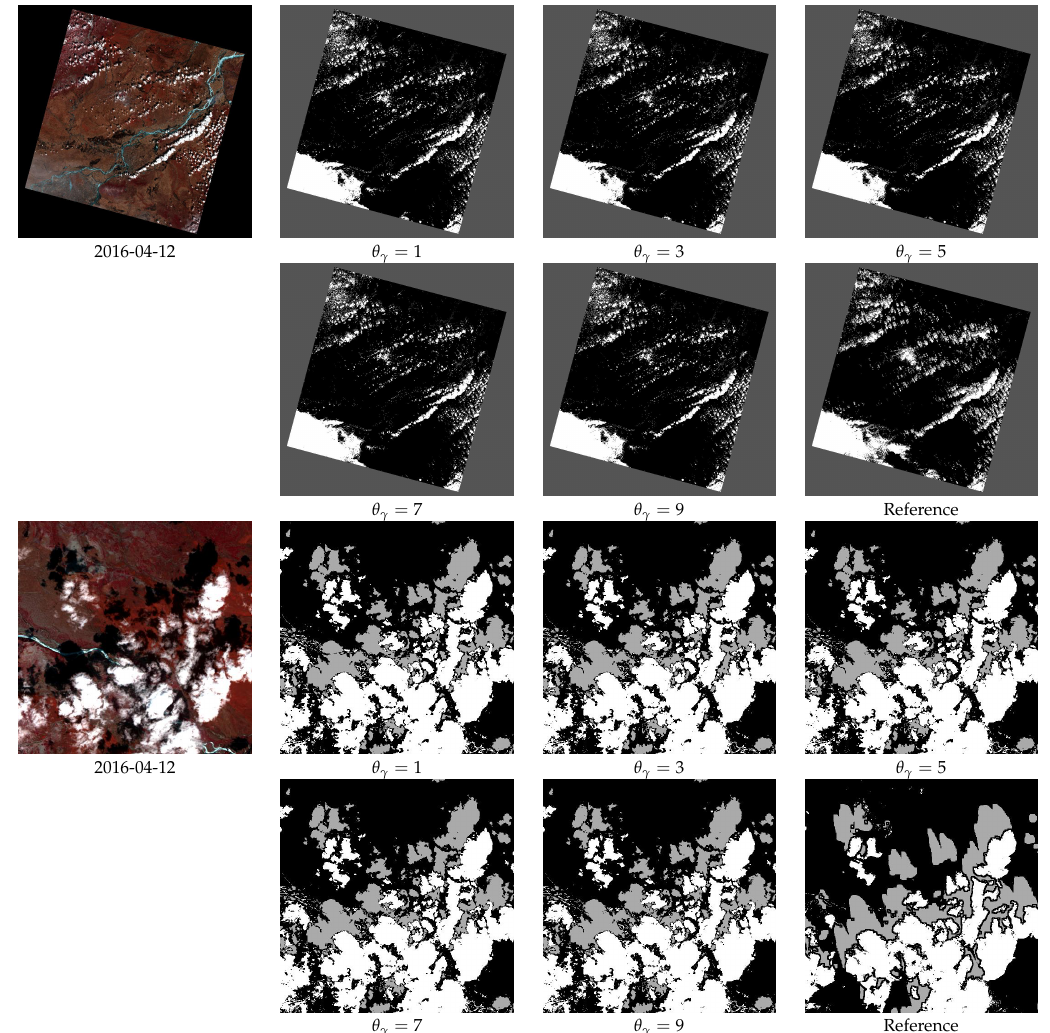
Figure 12. Visualizations with regards to θ γ of Dense CRF postprocessing. The candidate values of θ γ vary from 1 to 9 while θ α and θ β are secured to 91 and 11. It can hardly be seen that there is a significant visual improvement if θ γ